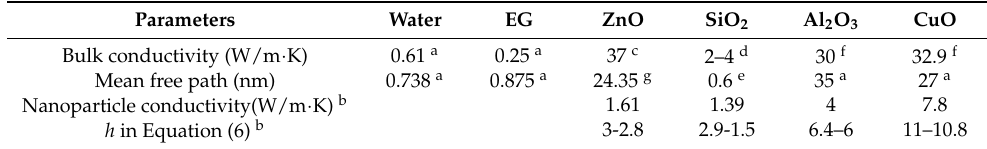
Table 1. The nanoparticle and base fluid data at T = 300 K.